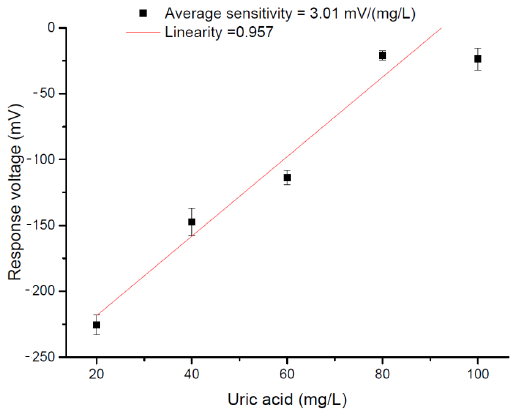
Figure 10. Uricase – rGO/NiO uric acid biosensor under a uric acid concentration range of 20 – 100 mg/L .